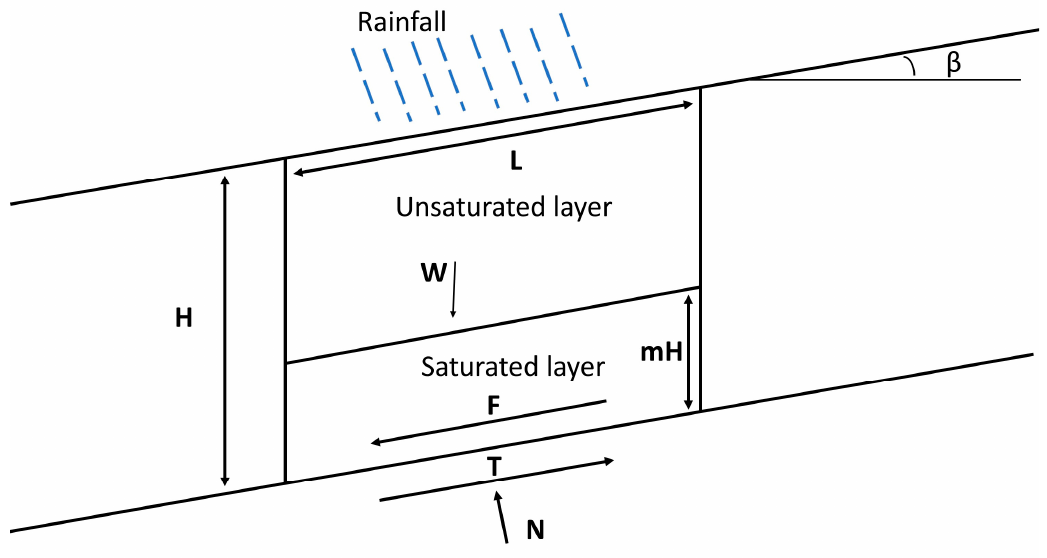
Figure 7. Forces acting on soil mass in an infinite slope. N is the normal force, W is the weight of the soil mass, S is the shear strength of soil along the failure plane, H is the height of the slope, β is the slope angle, L is the width of a slice, and mH is the thickness of the saturated layer.